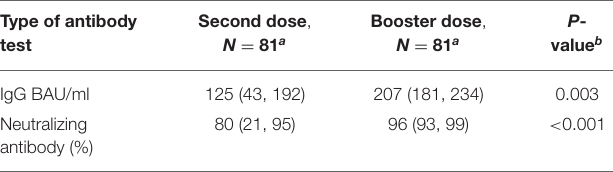
Type of antibody